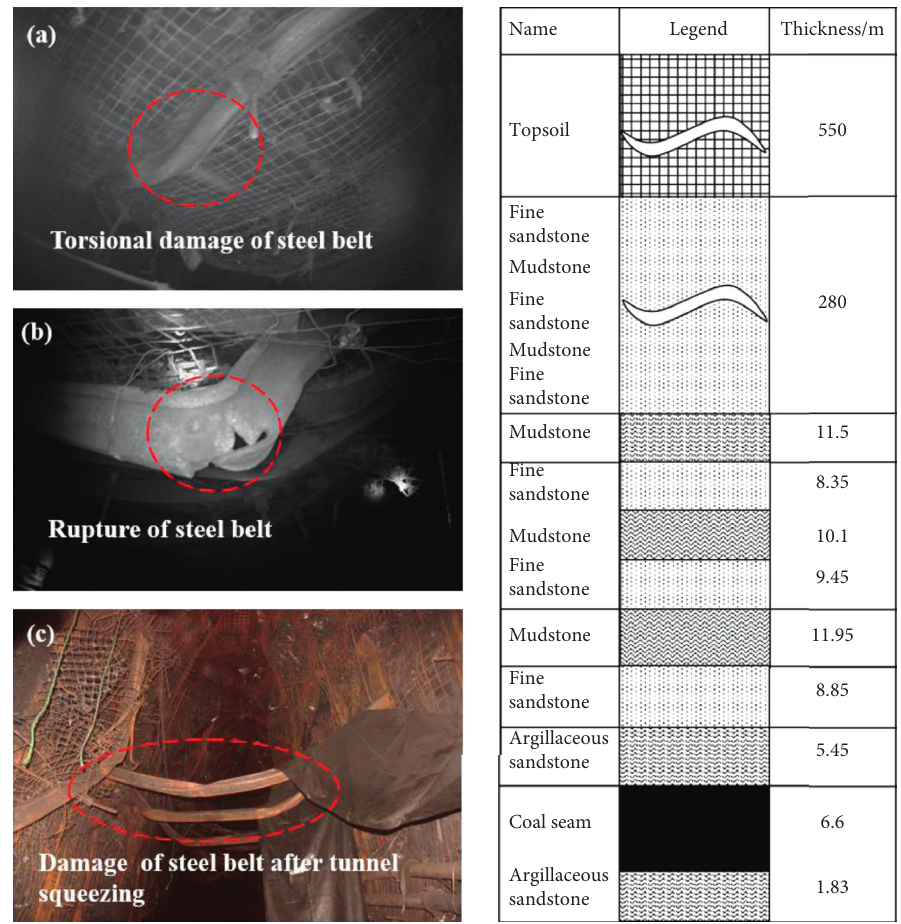
Figure 3: Photos of rockburst that occurred on 5th September 2014 (a), 5th September 2014 (b), and 1st September 2015 (c) and lithologic distribution in the main